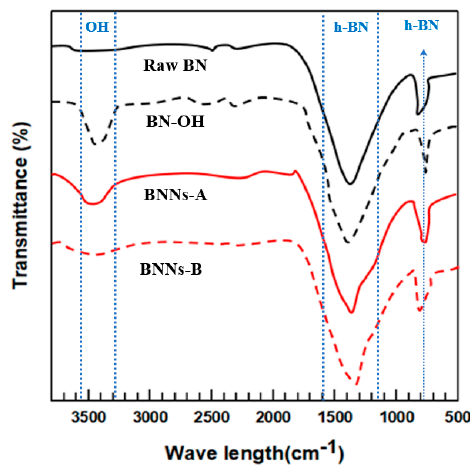
Figure 1. FT-IR spectra of raw BN, BN-OH, BNNs-A and BNNs-B.